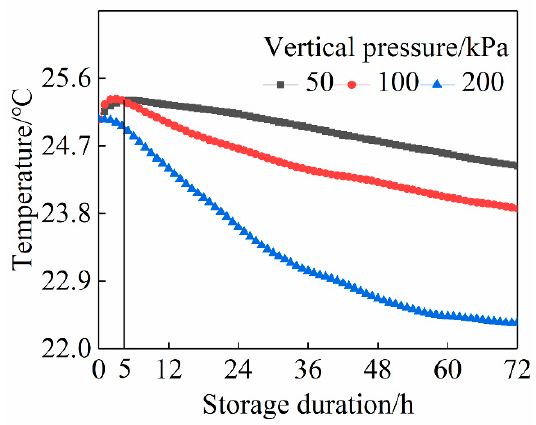
Figure 3. Average temperature variation at the middle plane under different pressures.